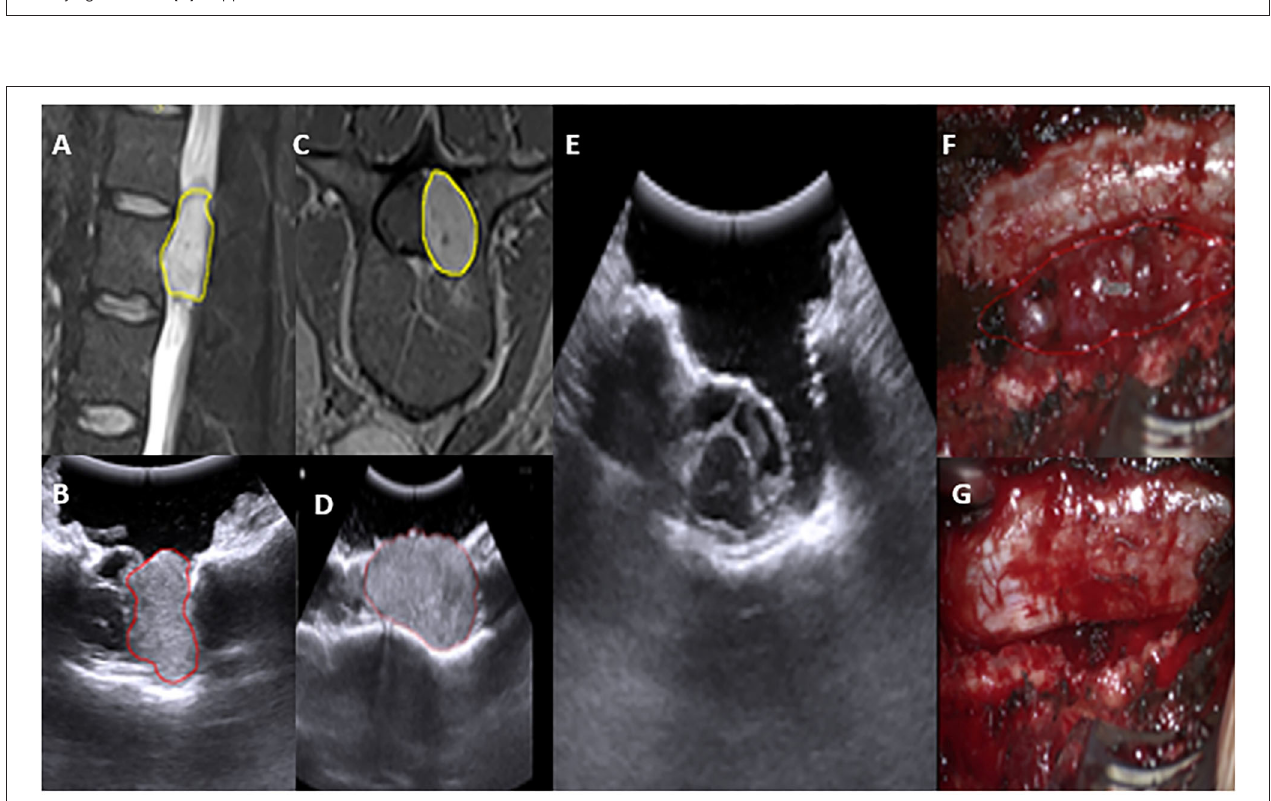
FIGURE 9 | Preoperative MRI T2WI sagittal and axial view depicting an extradural L2–3 lesion (A,C) yellow. In concordance, IUS depicting the lesion-location with spinal cord boundary (B,D) . Post-operative IUS Clearly shows total resection (E) . Intraoperative images, prior and post-resection (F,G) .